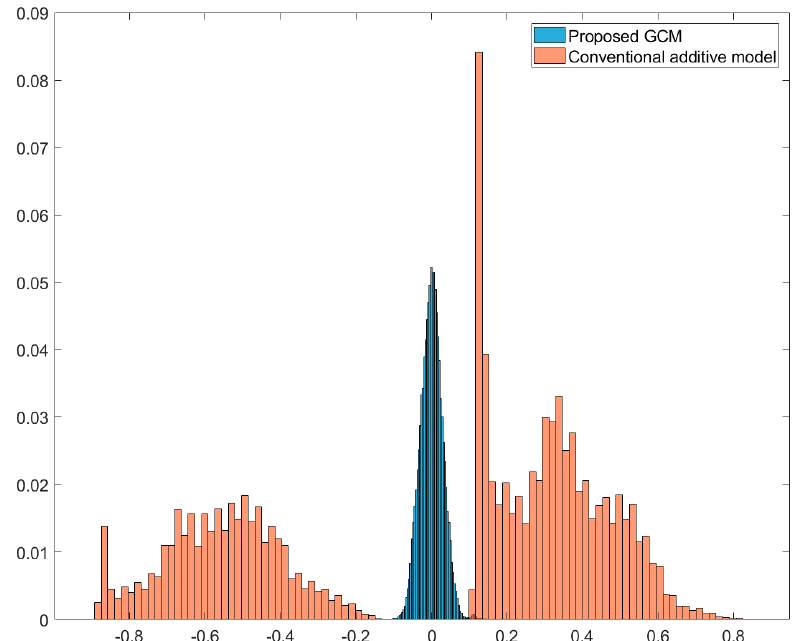
Figure 3. Histogram comparison of two types of residual layers generated using the conventional additive model and the proposed GCM.